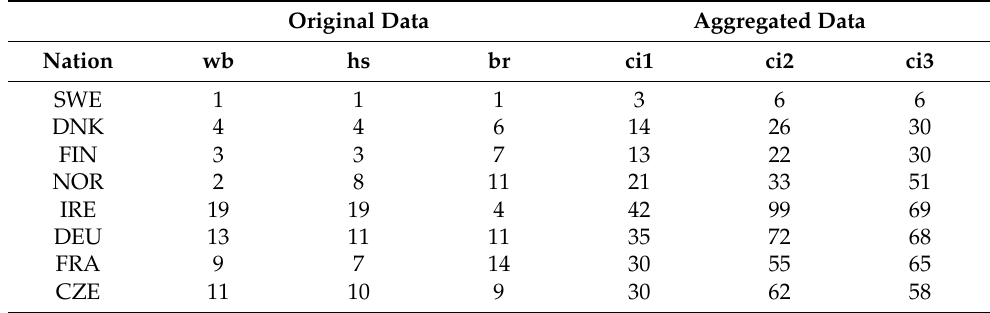
Table 2. Data for the exemplary